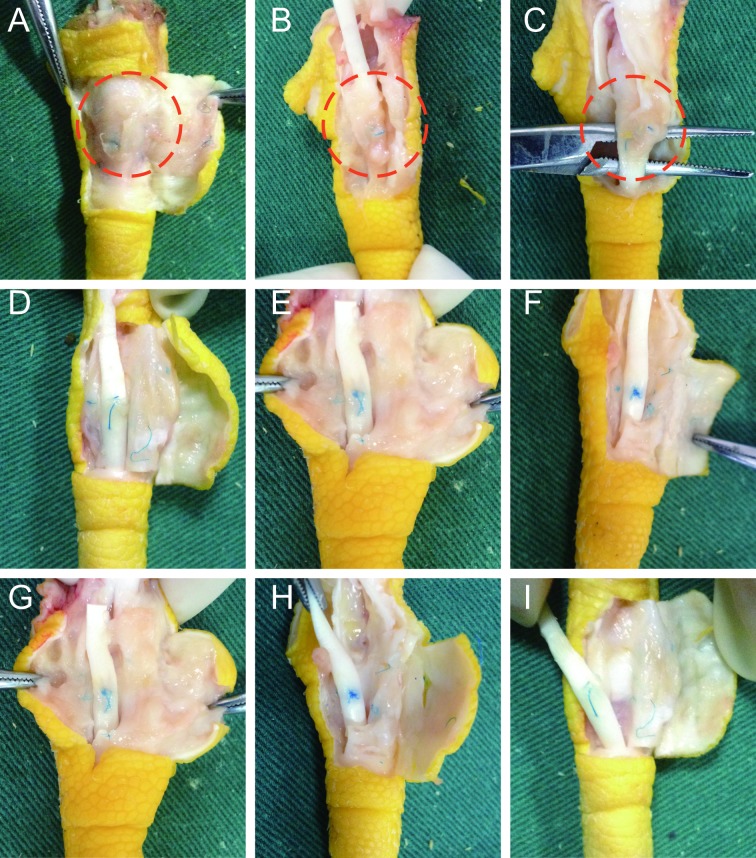
General observation of each group at the 2,4,8 week after operation.(A,B,C) No complete tendon sheath was observed in the control group. The tendon anastomosis was connected with fibrous connective tissue, which was firm and difficult to remove around the tendon tissue. The red circle refers to an adhesion formed between the tendon and the surrounding tissue. In the medical membrane group (D,E,F) and amniotic membrane group (G,H,I), the tendon sheath was reconstructed, and the tendon anastomosis healed well without adhesion. The medical membrane was vaguely visible while the amniotic membrane was unrecognizable.